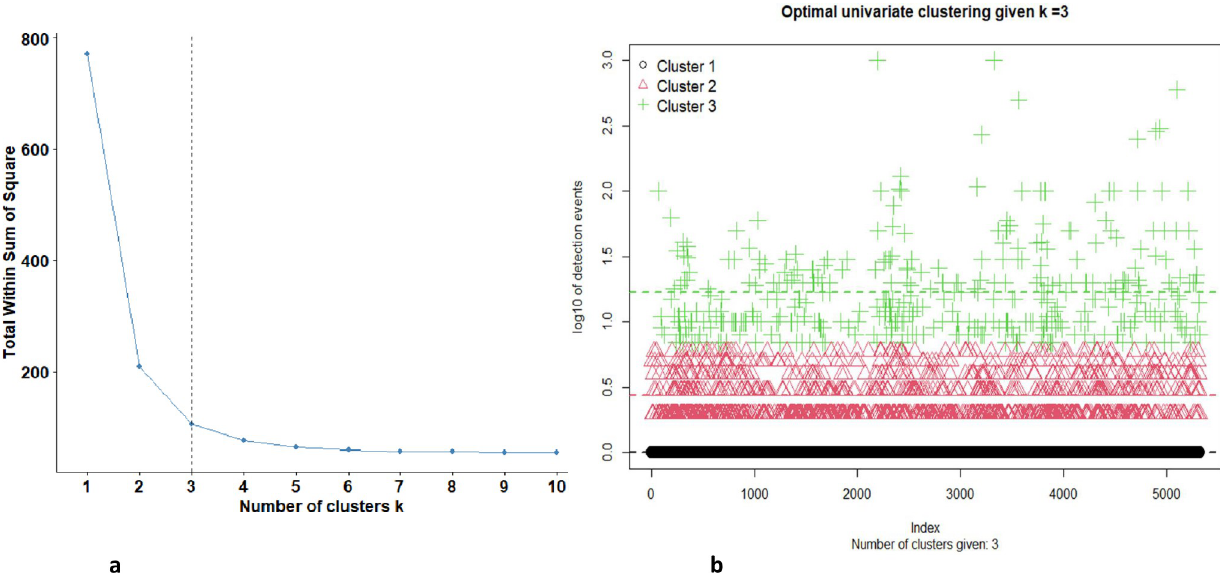
Fig 5. Determining the optimal number of clusters and showing the distribution of the data. a. Scree plot for optimal number of clusters using univariate clustering using ckmeans algorithm for log-transformed data using detection data for Barrow Island from 2009 to 2015. b. Univariate clustering using ckmeans algorithm for log10- transformed data using data for Barrow Island from 2009 to 2015.